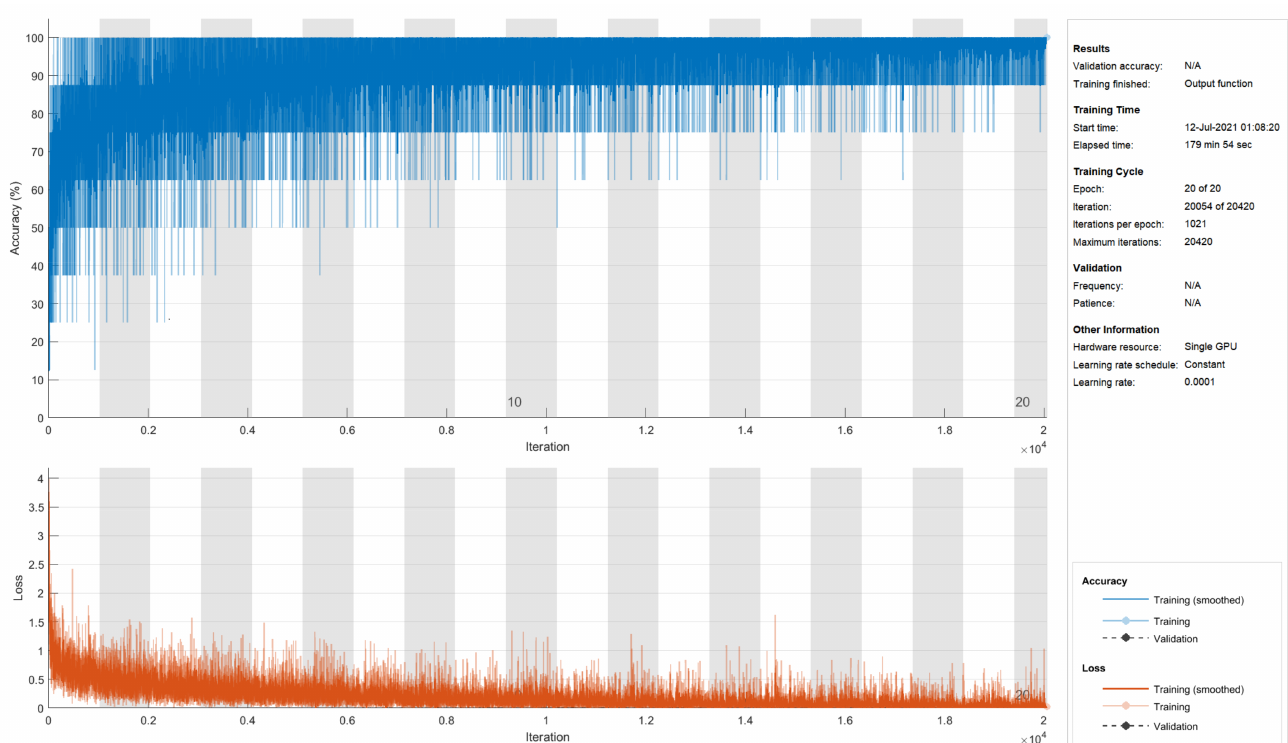
Figure 4. Training progress of the CNN GoogLeNet trained with five categories and a balanced database.